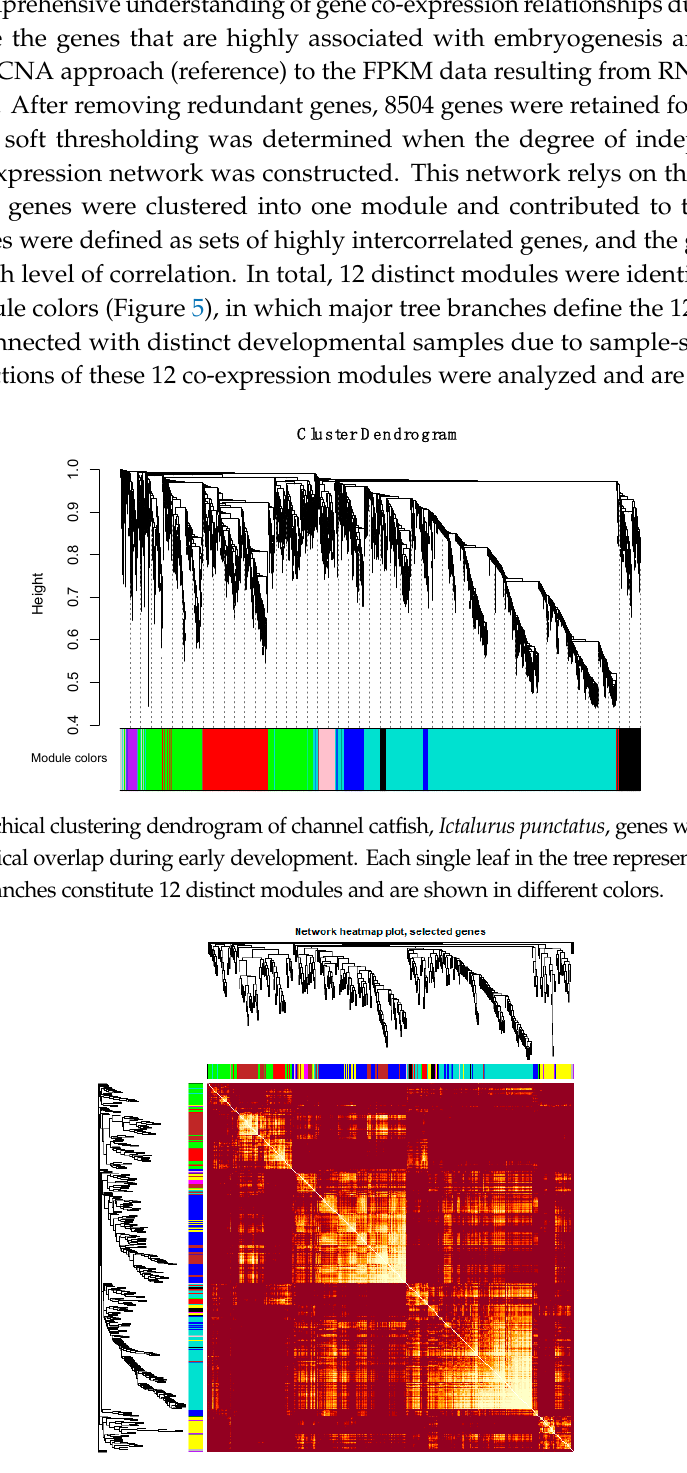
Figure 6. Heatmap plot of the gene network in channel catfish, Ictalurus punctatus . The heatmap shows the Topological Overlap Matrix (TOM) among all genes in the analysis. Light color represents high adjacency, and darker color represents low adjacency. The left and top sides indicate the gene dendrogram and module assignment.